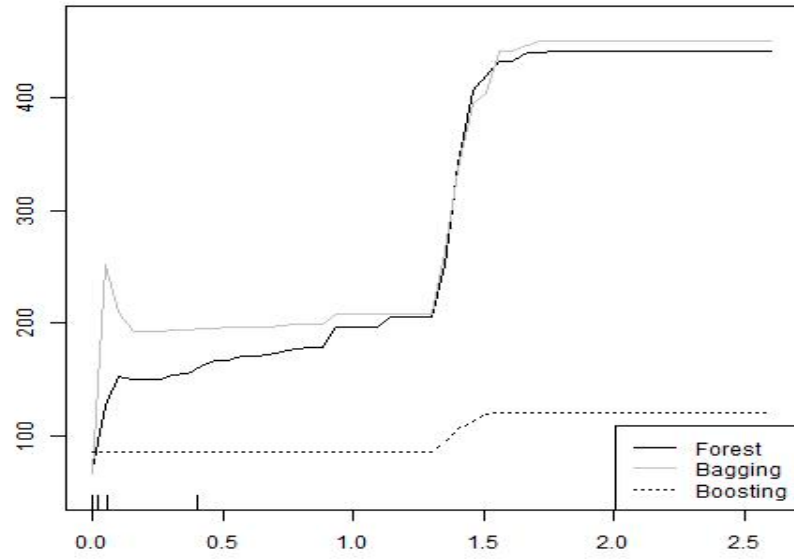
Figure 2. Partial dependence plot: guerrilla warfare.